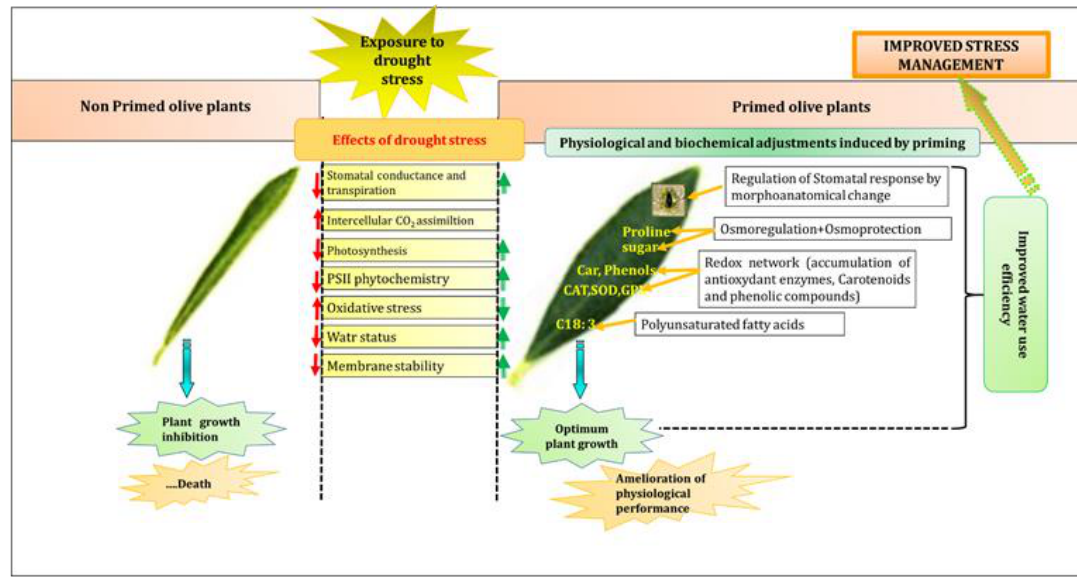
Figure 12. A model scheme for cross-tolerance responses (physiological and biochemical) responses in salt-primed plants relative to nonprimed ones.